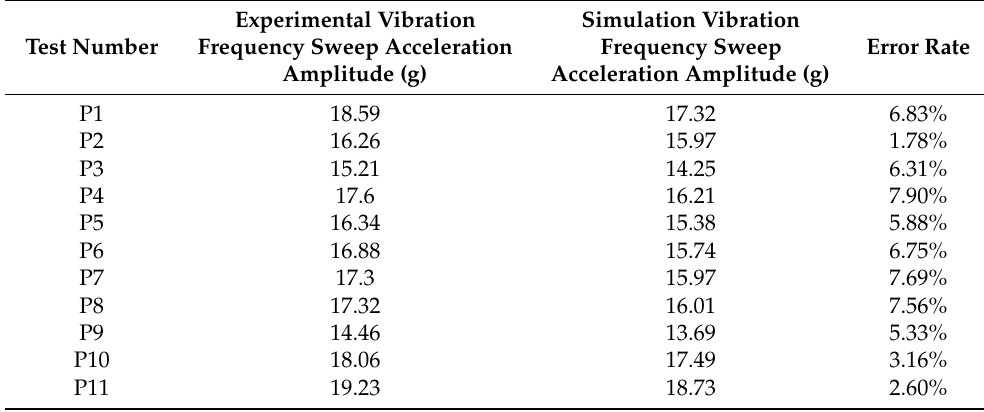
Table 14. Simulation and experimental data comparison of the aeronautical hydraulic clamp-pipeline system under frequency sweep excitation before and after